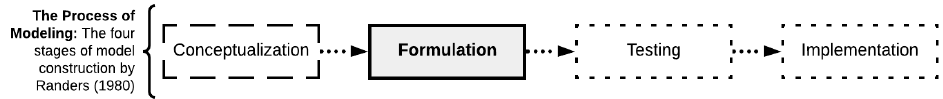
Figure 7. In the process of modeling, the next step after the conceptual modeling is formulation.